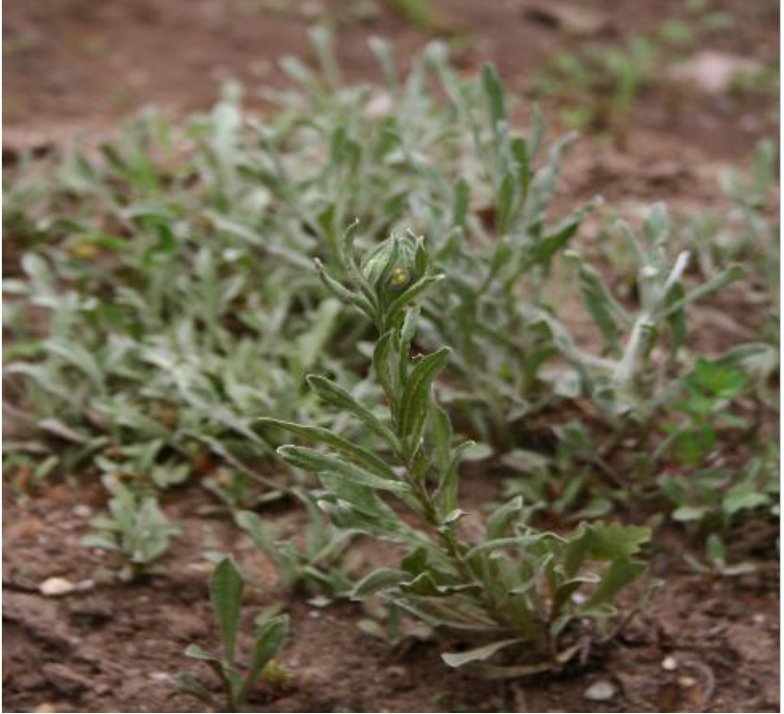
Figure 1. Helichrysum arenarium plants in the early stage of blooming (July 2013) at the “Dimitrie Brândză” Botanical Garden of the University of Bucharest, Romania (used with permission from Ref. [24]).